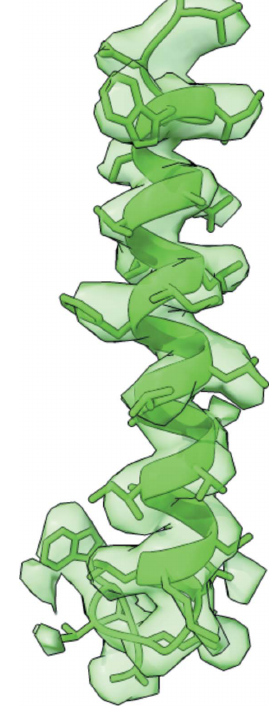
Figure 7 A model of the Voa1 assembly factor and a corresponding cryo-EM reconstruction at 3.5 A˚ resolution (PDB and EMDB IDs 6c6l and 7348, respectively) (Roh et al. , 2018). Only a residue range of 217–247 is shown for